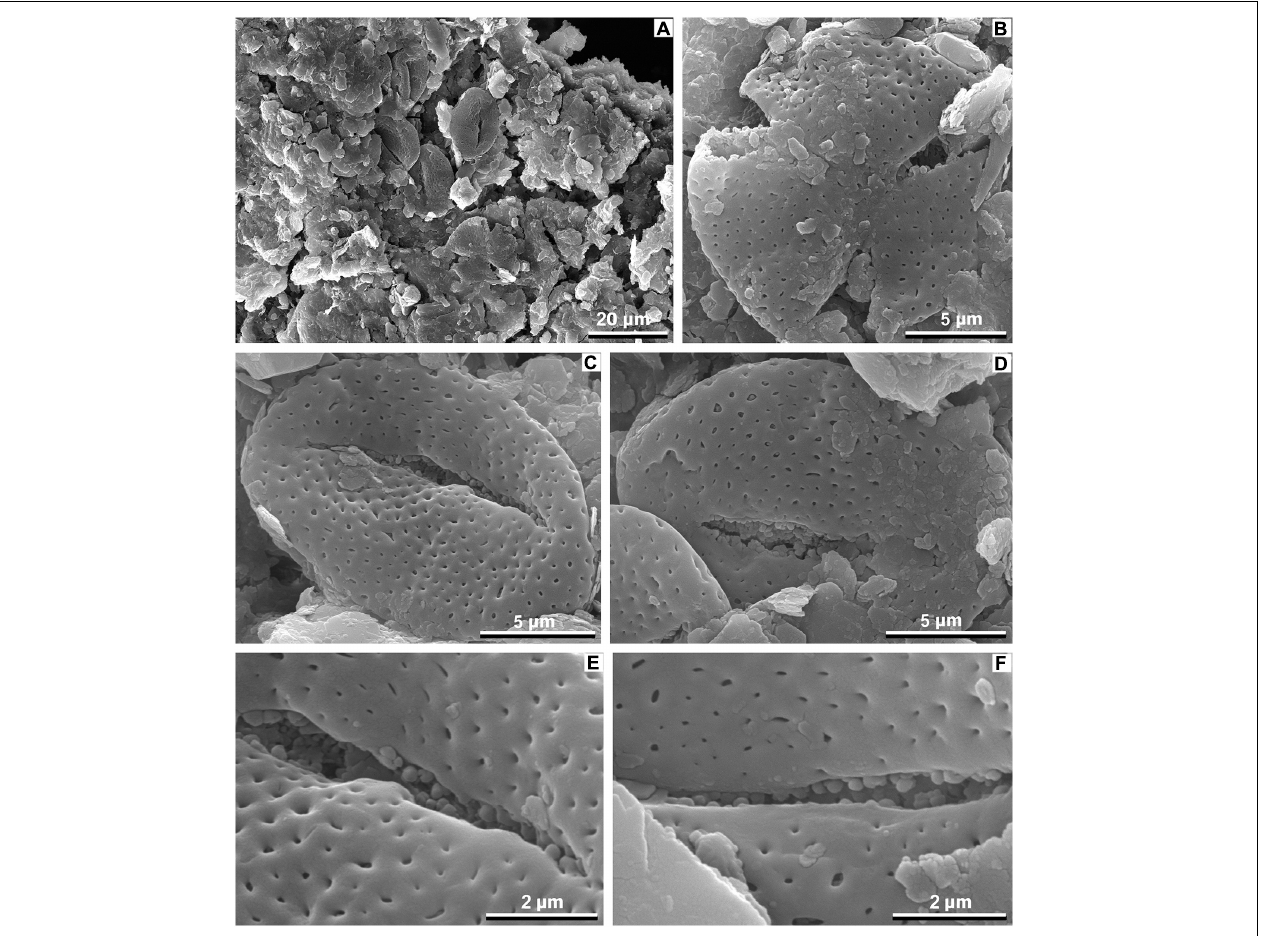
FIGURE 13 | Fossil pollen associated with M. eosinica sp. nov., MMJ3-837-3a, SEM. (A) A cluster of pollen grains found on the leaf of Meliosma . (B) A polar view of the single pollen grain, a smooth margo along the colpus is seen. (C,D) Single pollen grain, equatorial view, granular aperture membrane, and probable os in (C) are seen. (E,F) Close-ups with exine and aperture